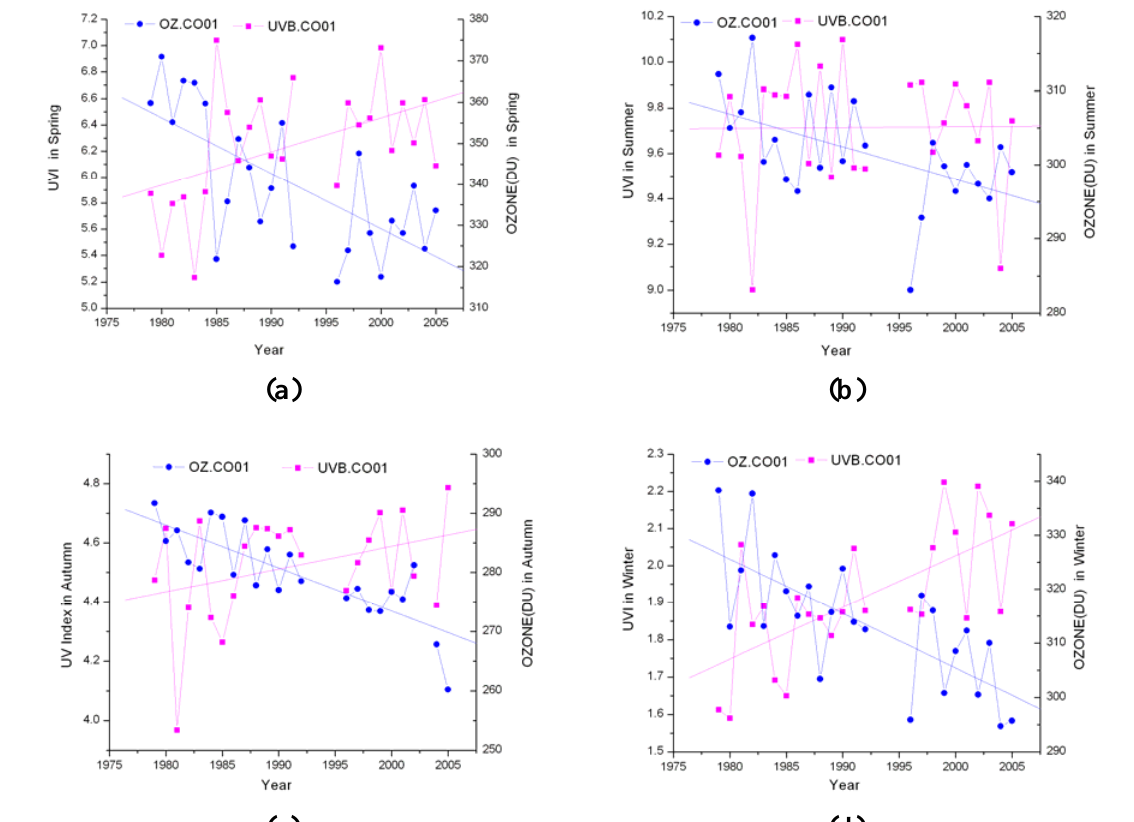
Figure 2. Seasonal trend analysis of the UVI and total ozone deviations relative to the yearly means with TOMS data. (a) CO01 multi-year seasonal variations in Spring; (b) CO01 multi-year seasonal variations in Summer; (c) CO01 multi-year seasonal variations in Autumn; (d) CO01 multi-year seasonal variations in